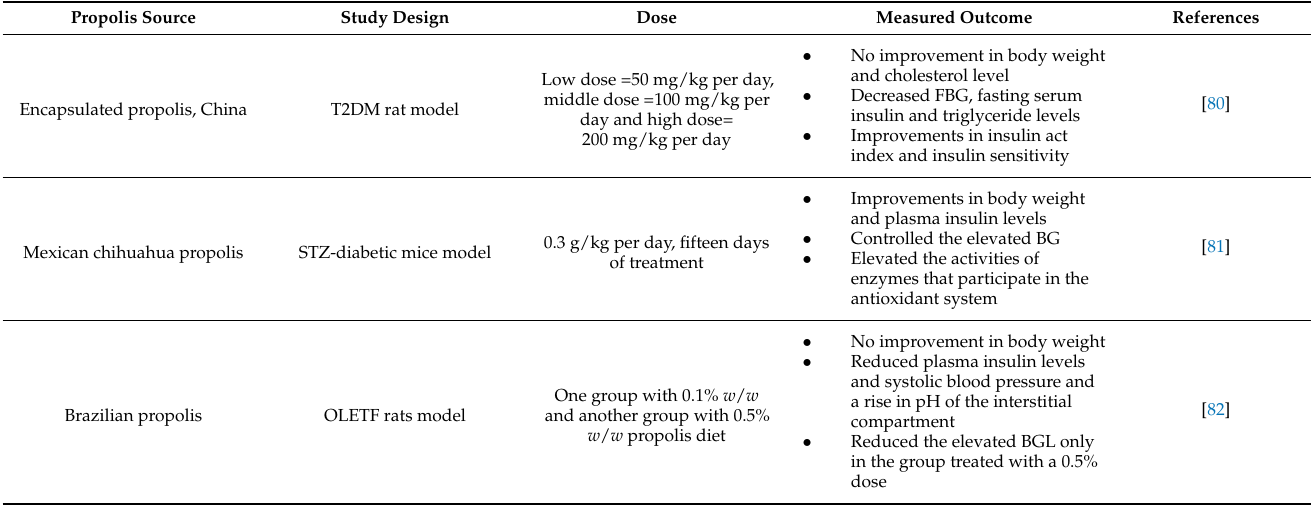
Table 6. Summary of clinical trials examining the activity of propolis and its constituents against